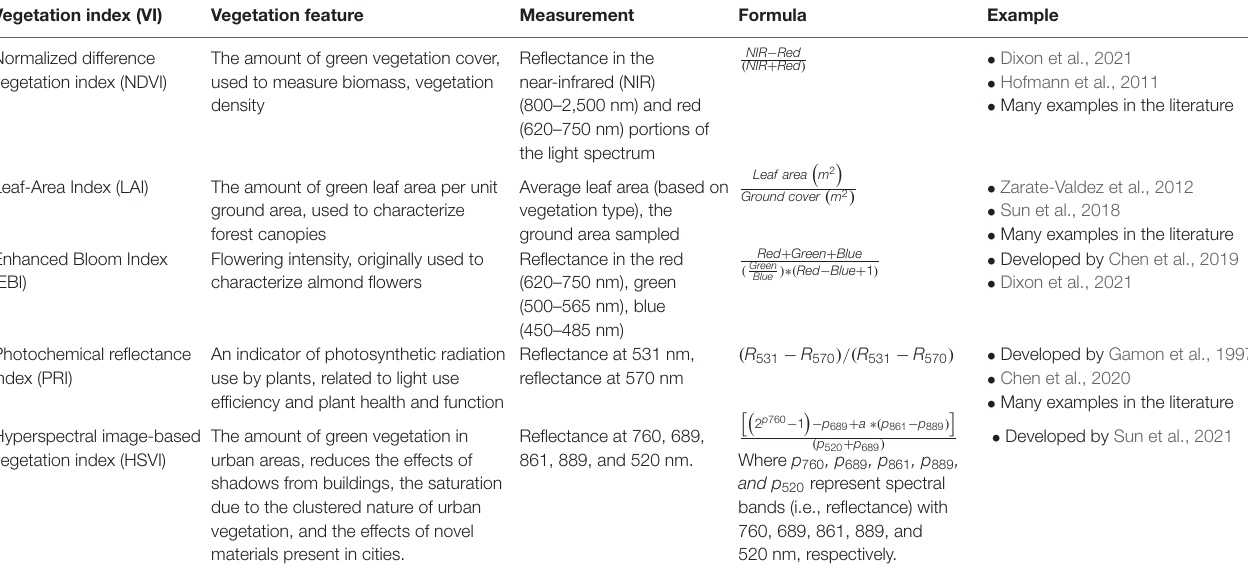
TABLE 4 | Examples of vegetation indices that are expressed as ratios between different portions of the electromagnetic spectrum reflected by vegetation on earth’s